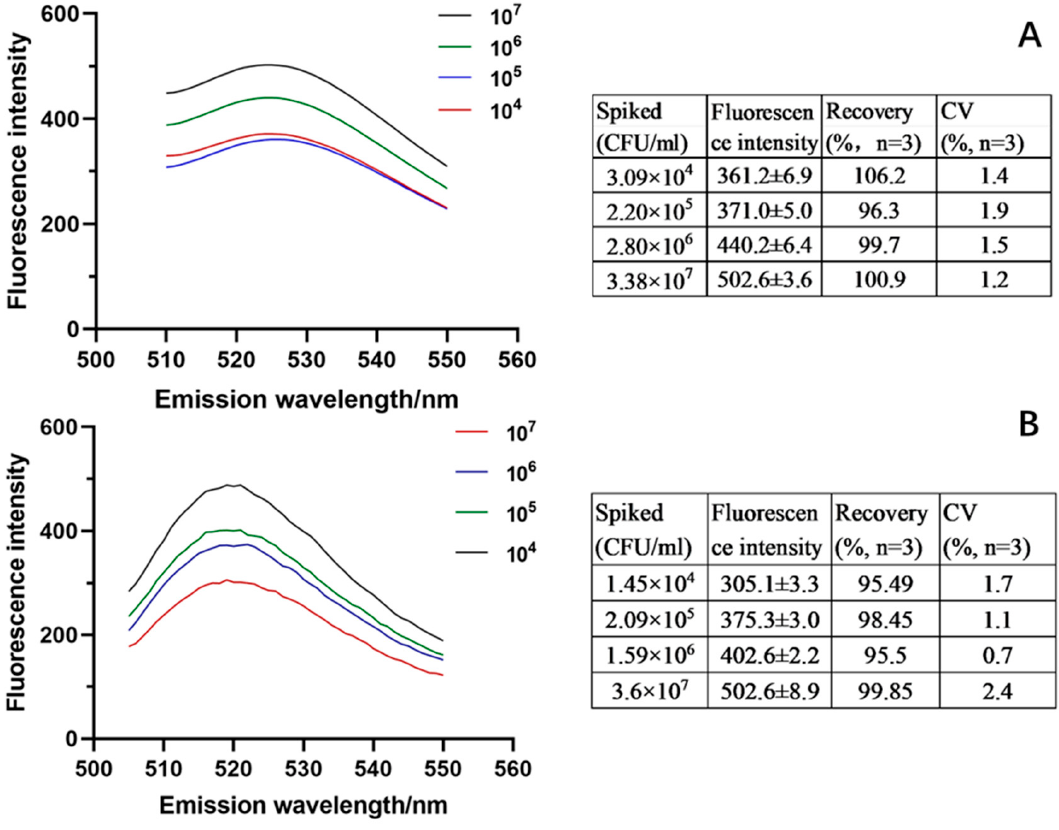
Figure 8. Plot of fluorescence intensity versus log of bacterial concentration in PBS.